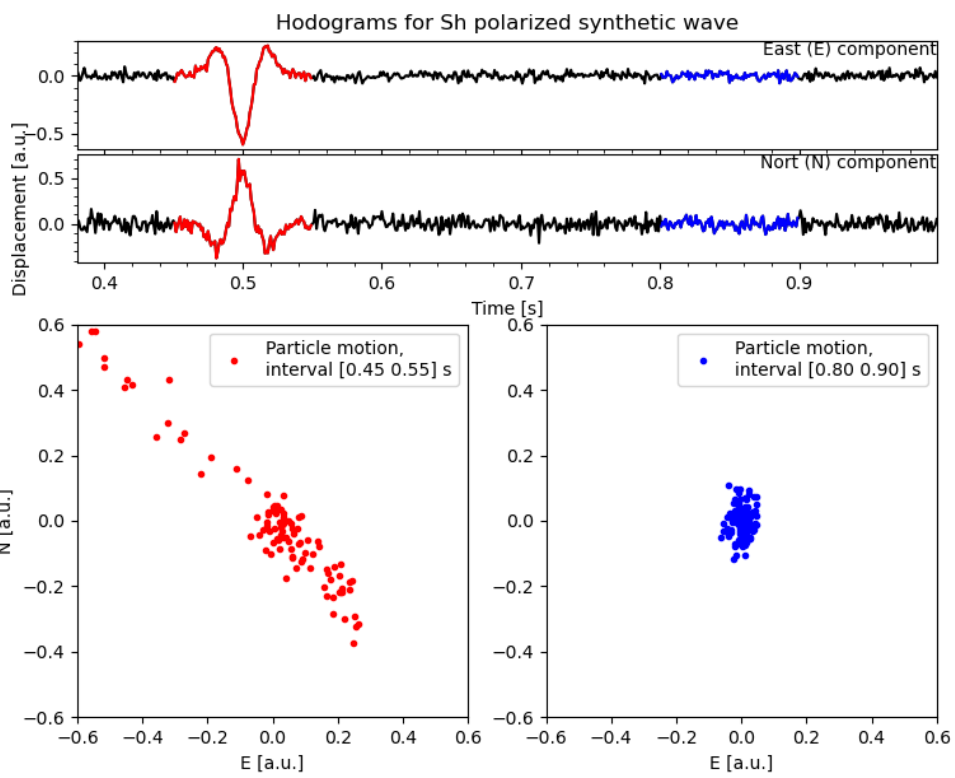
Figure 3. Synthetic SH wave decomposed on North and East direction ( top panel) and the relative hodograms in different frequency bands ( bottom